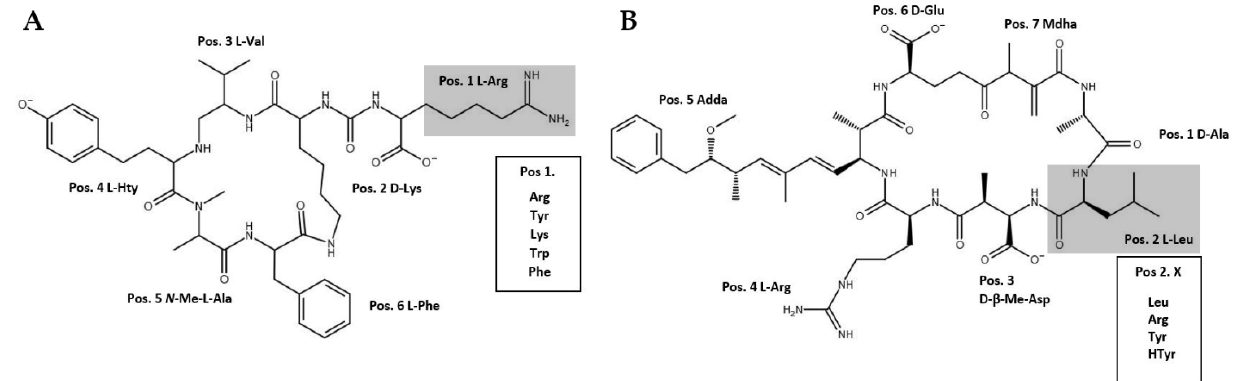
Figure 1. Naturally occurring ( A ) anabaenopeptin and ( B ) microcystin structural variants. Variable positions 1 in AP molecules and 2 in MC molecules are highlighted. The corresponding amino acids which may occur in these positions as observed in study organisms are shown in boxes.